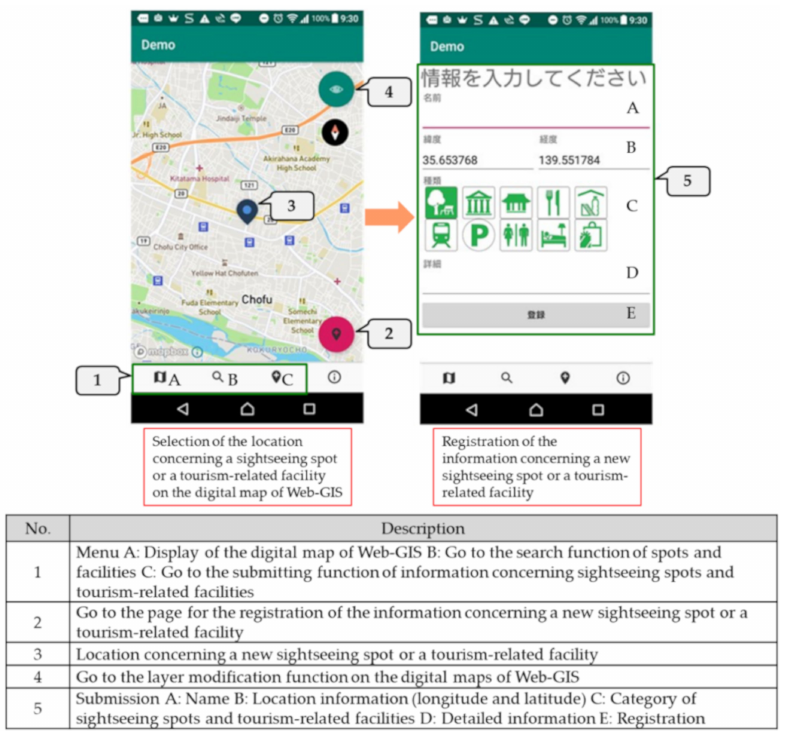
Figure 6. Screen for the submission function of information concerning sightseeing spots and tourism-related facilities.